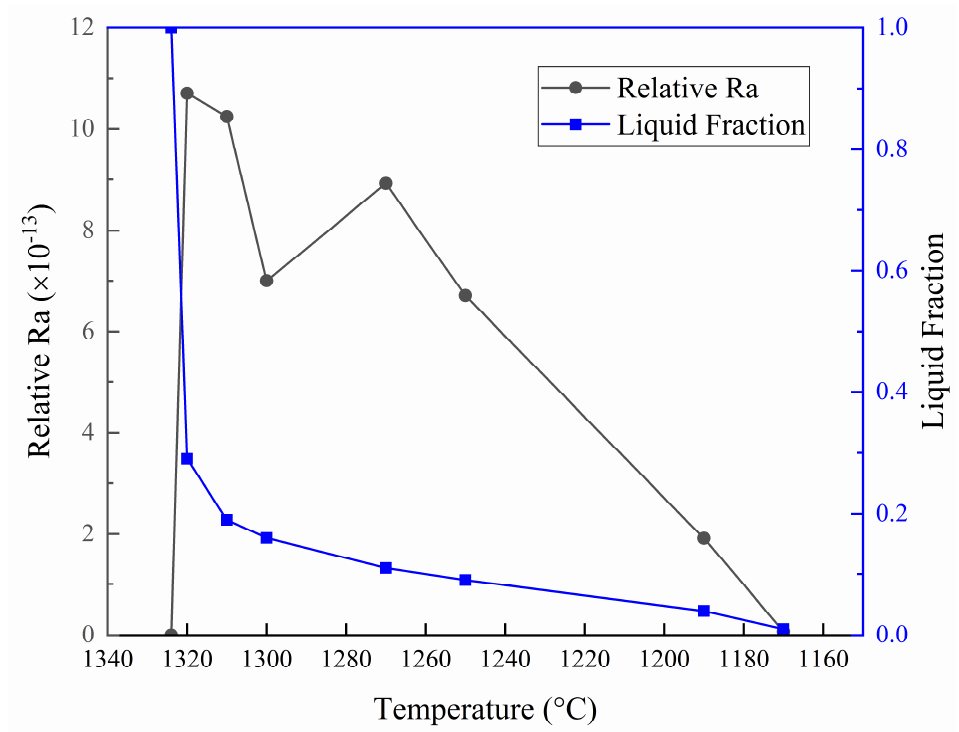
Figure 9. The relative Ra and liquid fraction during solidification at different temperatures.